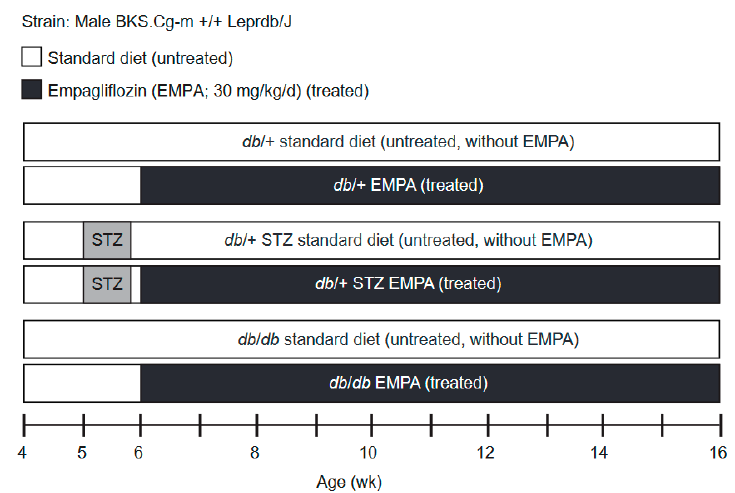
Figure 1. Study scheme and experimental timeline. Type 1 diabetes (T1D) db /+ streptozotocin (STZ), type 2 diabetes (T2D) db / db , and control db /+ mice cohorts were randomized at week 6 into